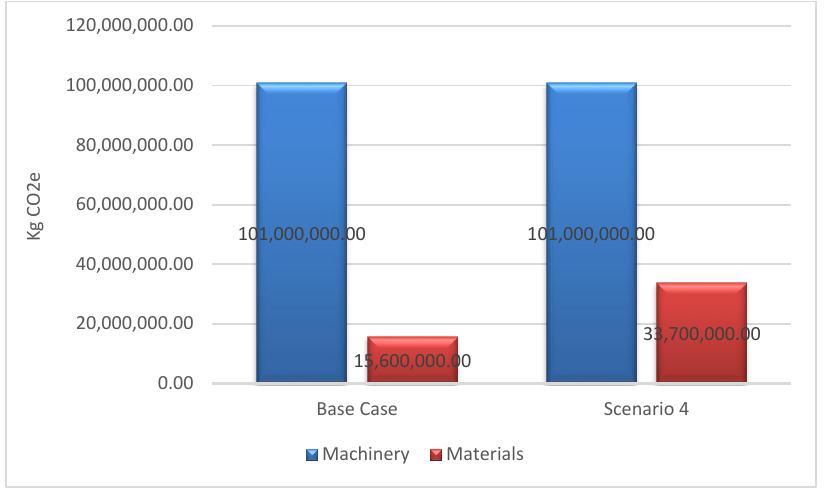
Figure 6. Results of CO2e kg emissions obtained in scenario 4 compared to the base result.